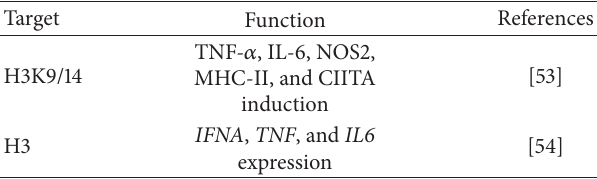
Table 3: HATs involved in macrophage